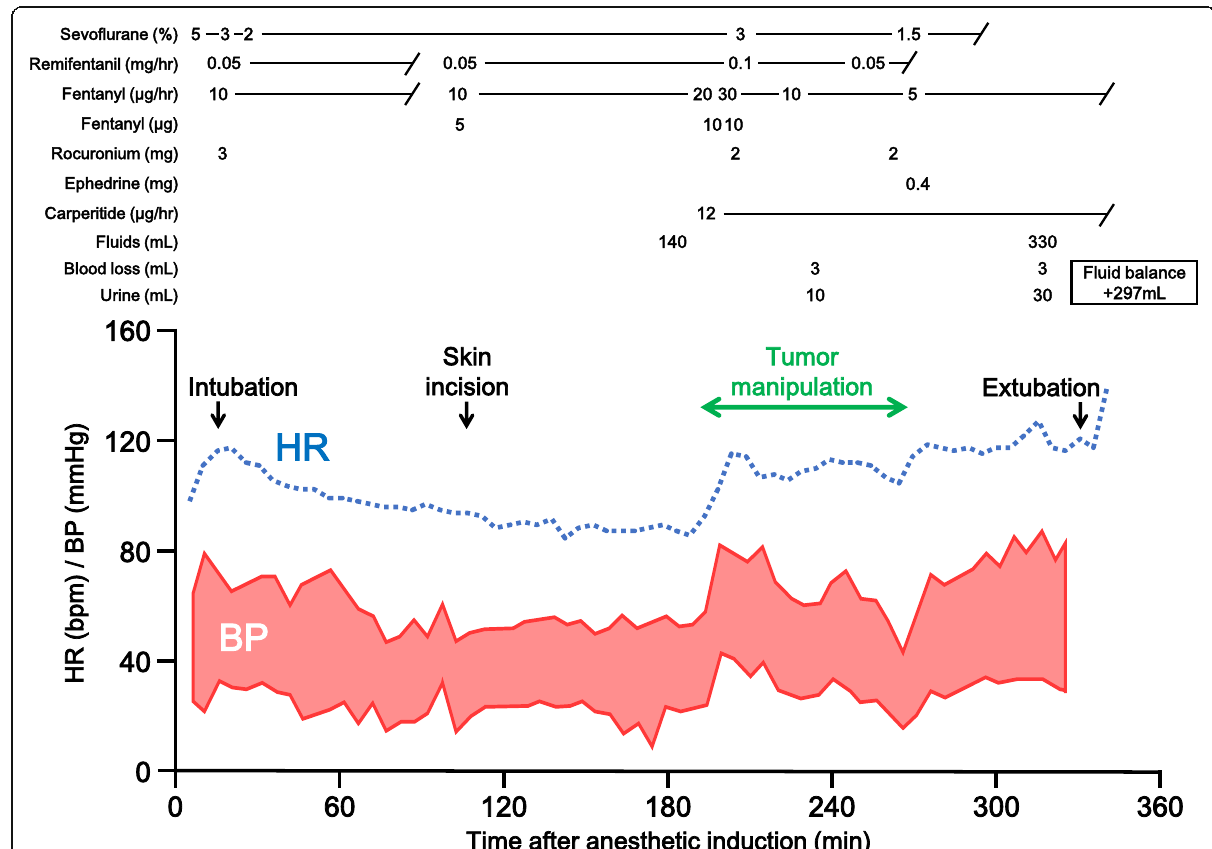
Fig. 2 Anesthesia record of an infant who underwent Wilms ’ tumor resection. HR: heart rate, BP: blood